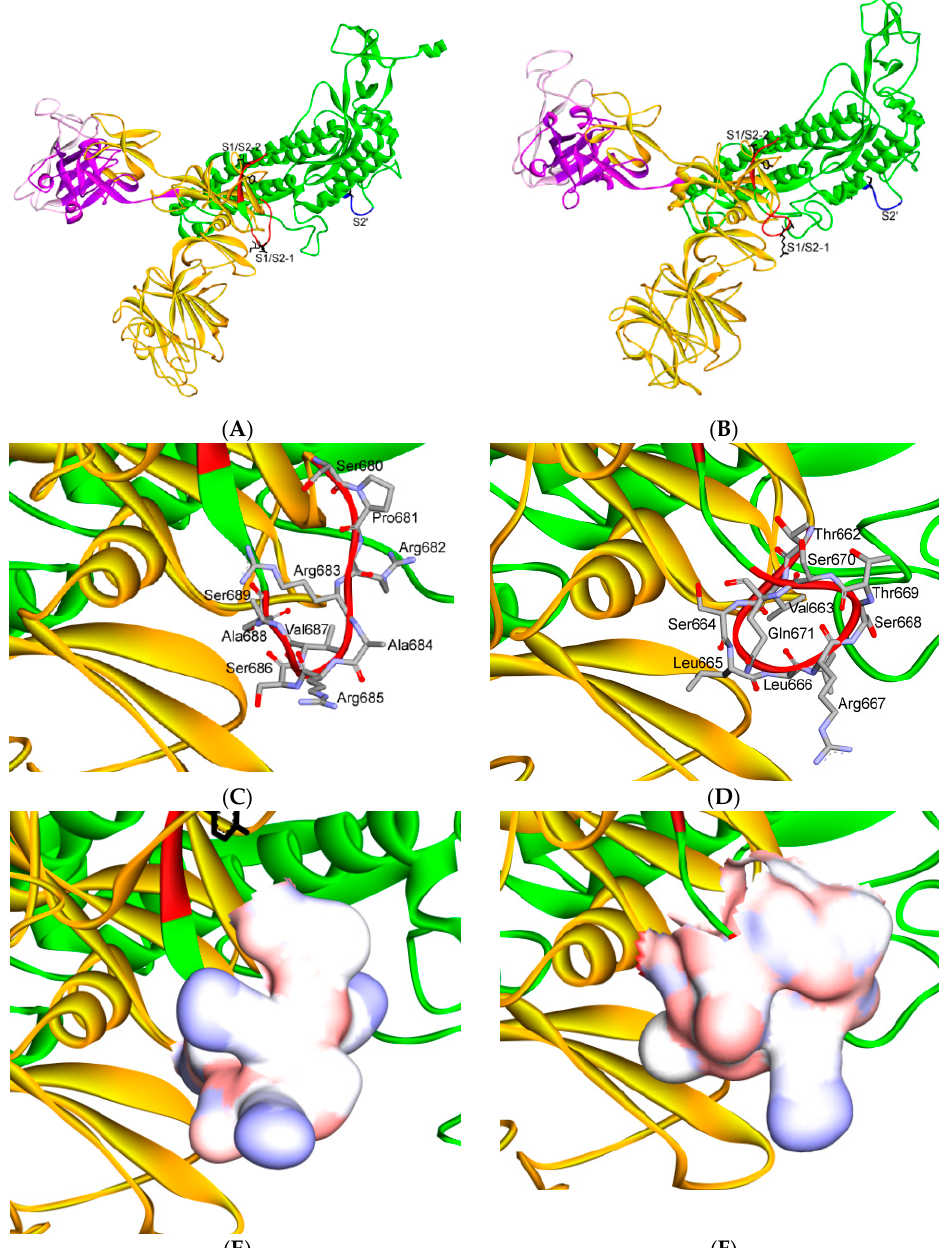
Figure 9. Three-dimensional structure of di ff erent furin-like cleavage sites for SARS-CoV and SARS-CoV-2. ( A , B ) show 3D models of the S protein of SARS-CoV and SARS-CoV-2, respectively. These have been predicted by homology modeling that used Swiss-model software, based on the S protein sequence obtained from Genbank (accession numbers: MT192773 and AY278741 for SARS-CoV and SARS-CoV-2, respectively). The models were predicted through use of PDB IDs 6ACD and 6VYB for SARS-CoV and SARS-CoV-2, respectively. The S2 unit, RBD, RBM, S1 / S2 and S2 (cid:48) potential cleavage sites are shown in green, violet, pink, red and blue, respectively. The S1 / S2-1 is more exposed to solvent than the S1 / S2-2 site, so it is more easily accessed and cleaved by furin in SARS-CoV-2. Therefore, it is a more potential e ff ective priming site. ( C , D ) show the detailed amino acid compositions of the S1 / S2-1 cleavage sites of SARS-CoV and SARS-CoV-2, respectively. ( E , F ) show the surface of the S1 / S2-1 cleavage sites of SARS-CoV and SARS-CoV-2, respectively. There are more basic groups in the S1 / S2-1 cleavage site of SARS-CoV-2 (shown in light blue color) than in that of SARS-CoV. 3D models were created using Discovery Studio (version 2.5.5, Biovia, San Diego, CA,